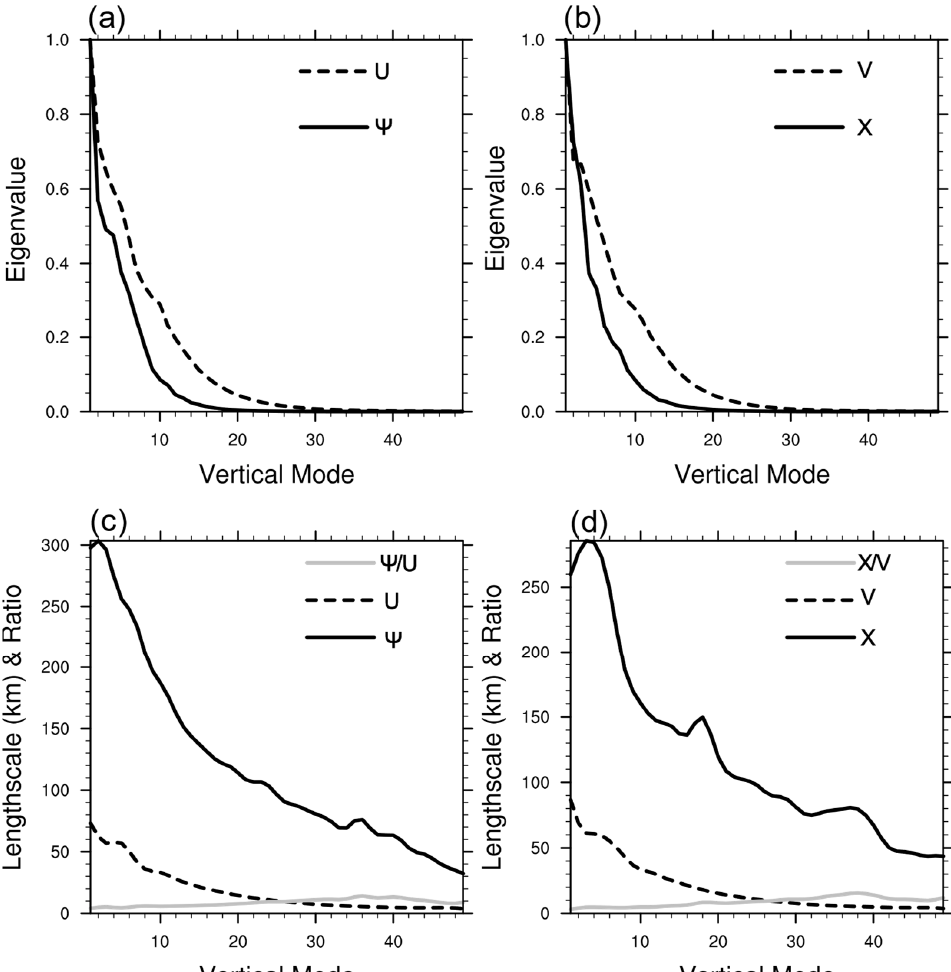
Figure 4. Eigenvalue rescaled by the first vertical mode (( a ) ψ and U; ( b ) χ and V) and length scale with the ratio (( c ) ψ , U and ψ /U; ( d ) χ , V and χ /V), with vertical mode.